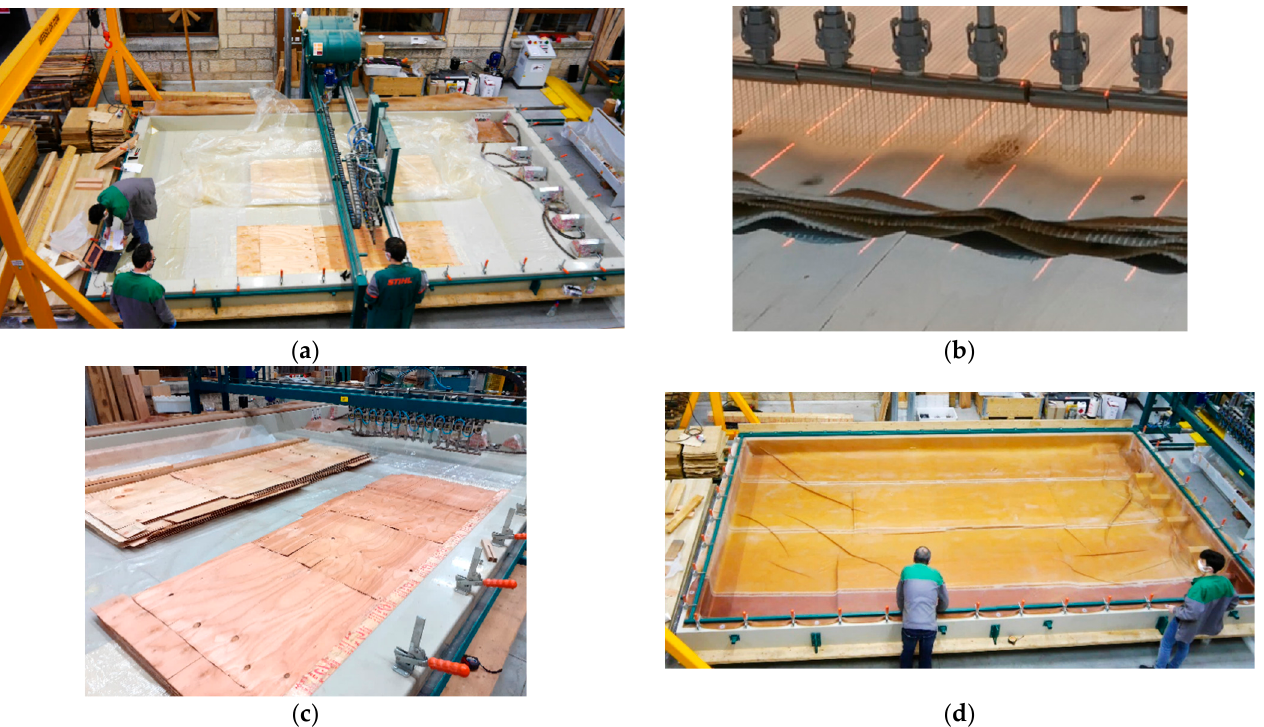
Figure 4. Panel manufacturing: ( a ) general view, ( b ) glue nozzles, ( c ) veneer positioning of plies, ( d ) pressing.